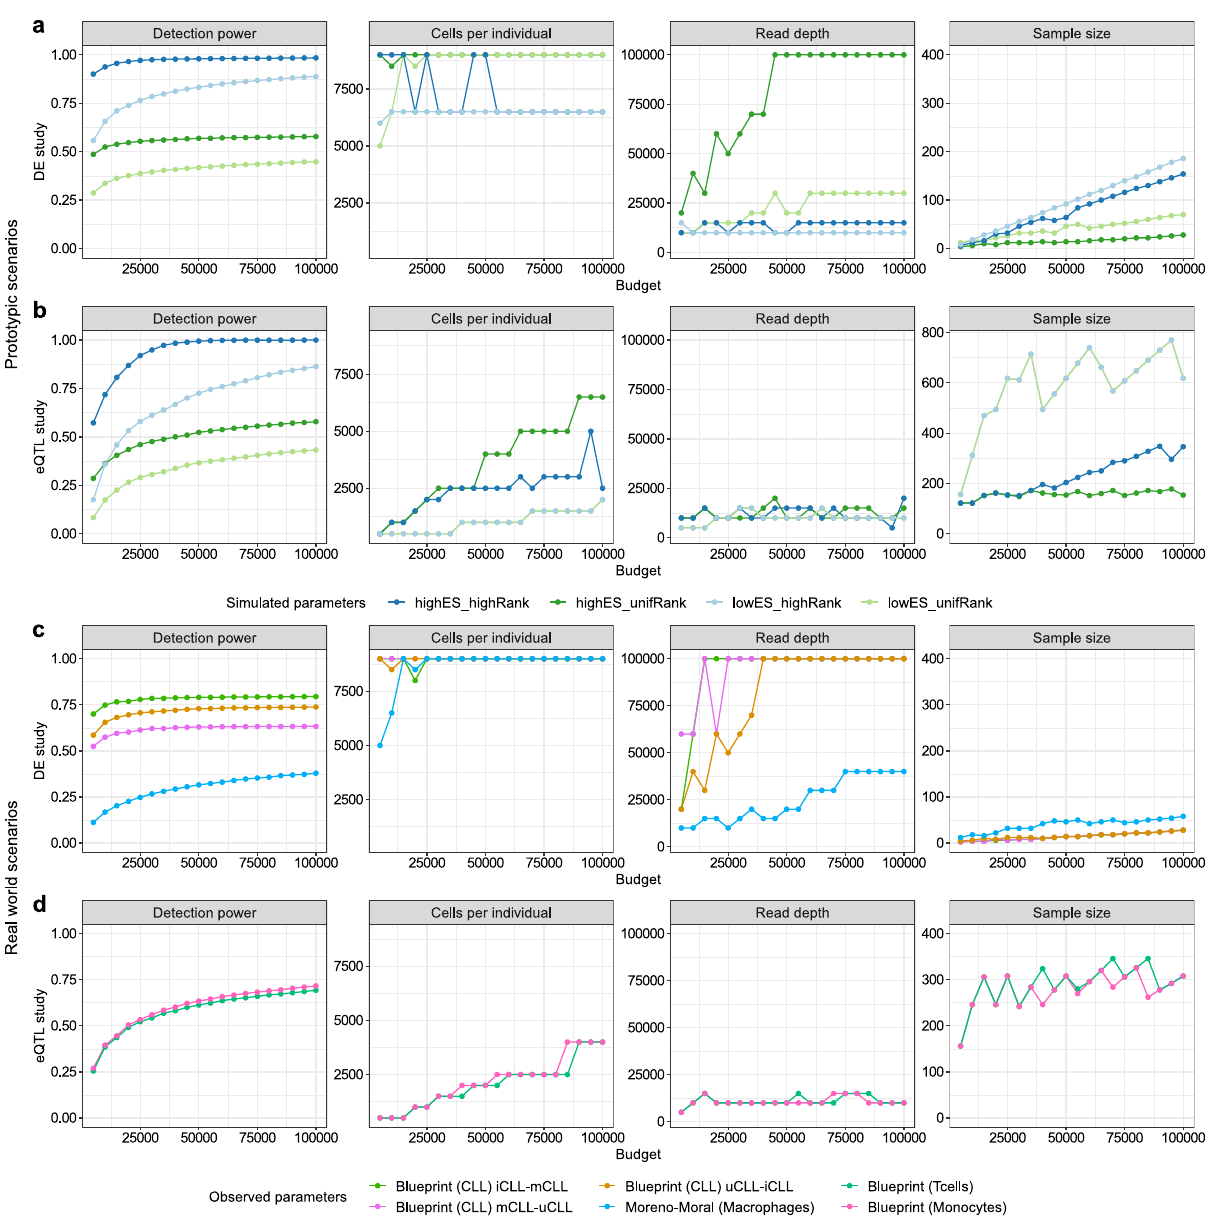
Fig. 5 Optimal parameters for varying budgets and 10X Genomics data. The maximal reachable detection power (column 1) and the corresponding optimal parameter combinations (columns 2 – 4) change depending on the given experimental budget (x-axis). The coloured lines indicate different effect sizes and gene expression rank distributions. Different simulated effect sizes and rank distributions for DEG studies ( a ) and eQTL studies ( b ) with models fi tted on 10X PBMC data. highES = high effect sizes, lowES = low effect sizes, highRank = high expression ranks and unifRank = uniformly